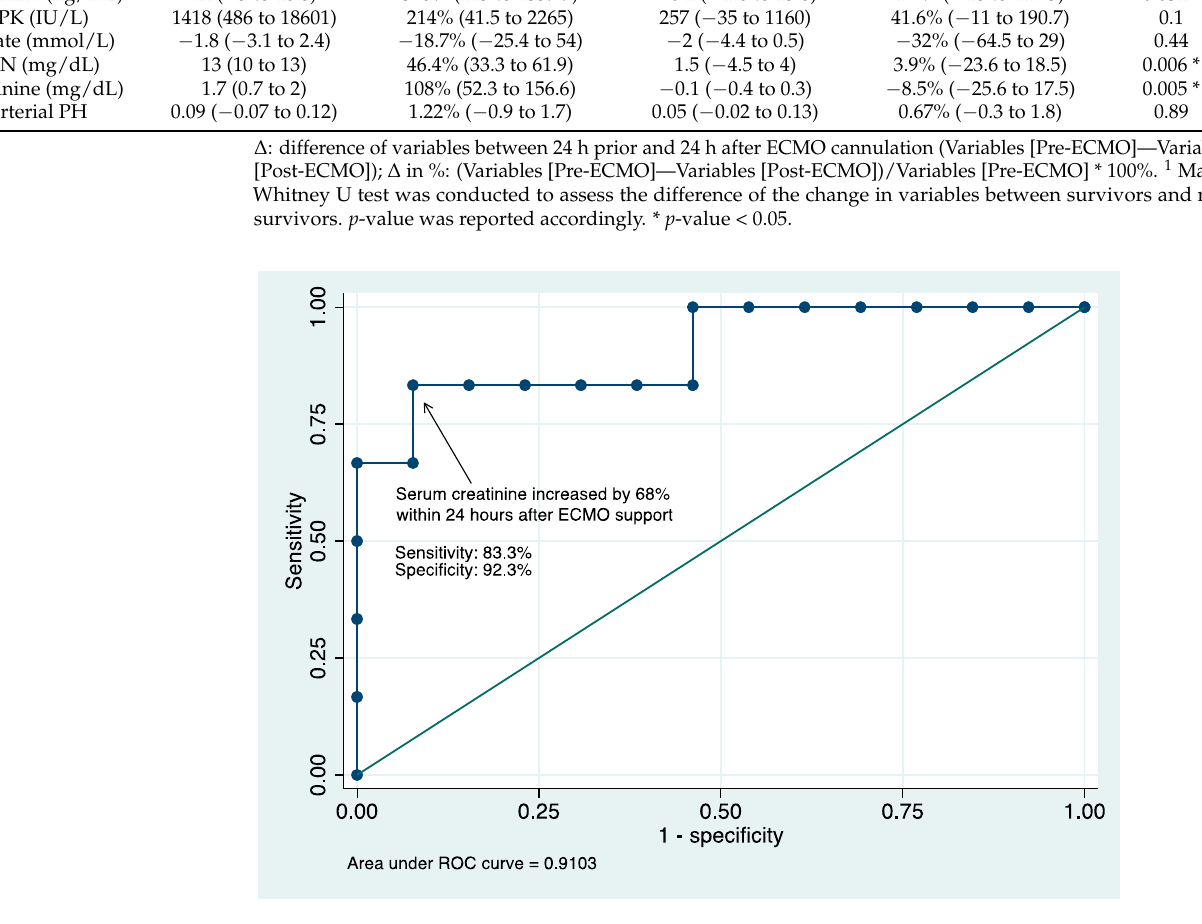
Figure 3. Receiver operating characteristic curve: Differences of serum creatinine within 24 h before and after ECMO cannulation in predicting in-hospital mortality.